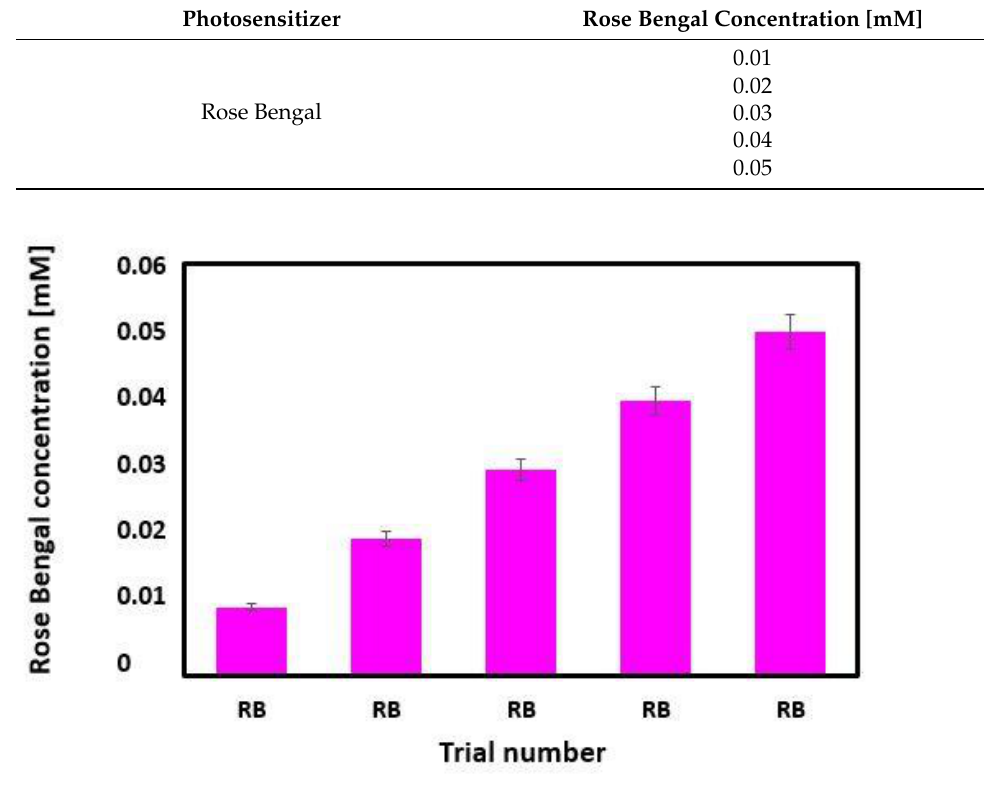
Figure 2. Bar plot of Rose Bengal